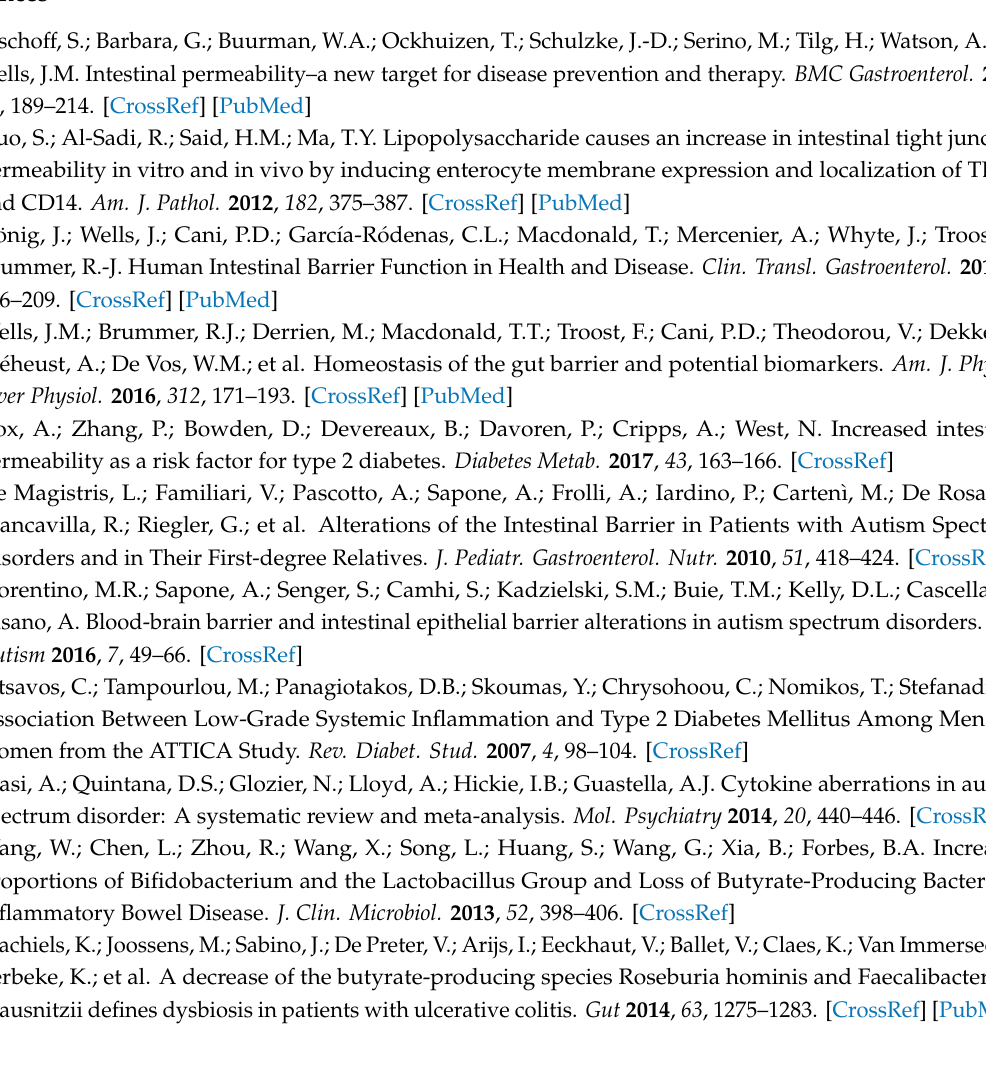
Figure S1: E ff ects of butyrate on intestinal permeability in colonic biopsies from all participants; Table S1: Age and sex distribution in the study population and in its subgroups; Table S2: Absolute transepithelial electrical resistance (TER) values (mean ± s.d.); Table S3: Correlation analysis between age and intestinal permeability and between sex and intestinal